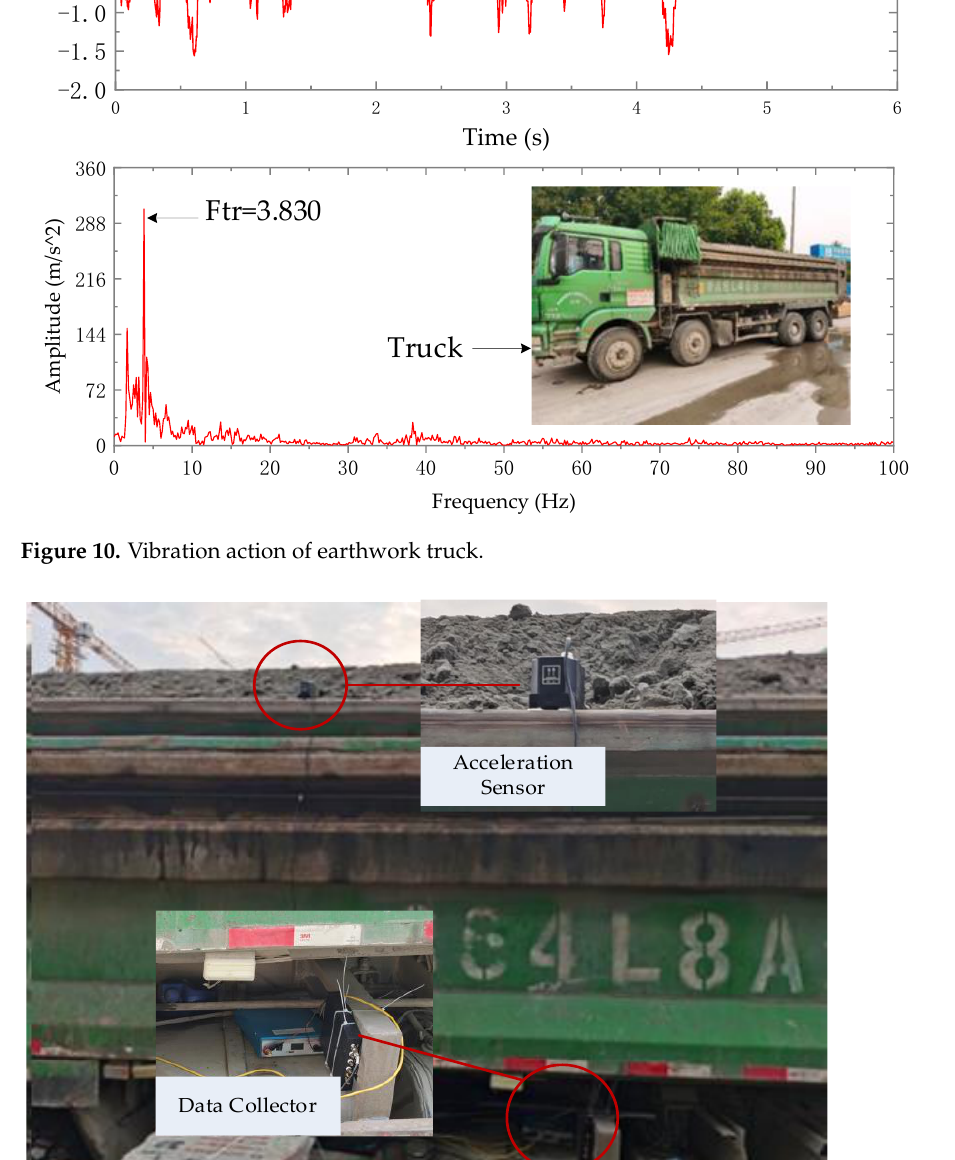
Figure 11. Test system of vehicle vibration.